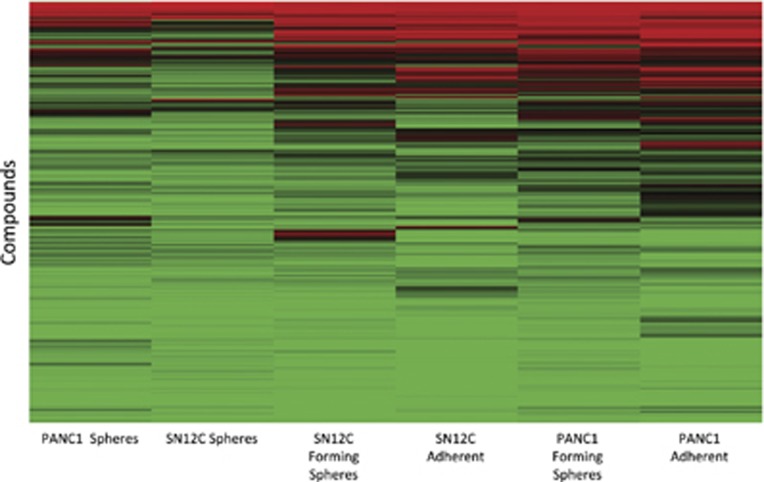
Pharmacological responses of the MIPE collection in PANC1 and SN12C in 2D monolayer, 3D spheres and cells forming spheres. Heat map of hierarchal clustering of % activity for each compound at the maximum concentration tested (46 μM). The clustering displays both cancer types in all three growth modes, differentiated cells in 2D monolayer, cells forming spheres, and 3D spheres. Gradient of colors from red (0% viability), black (50% viability) and green (100% viability). Clustering was done using the Hierarchical clustering function in TIBCO Spotfire